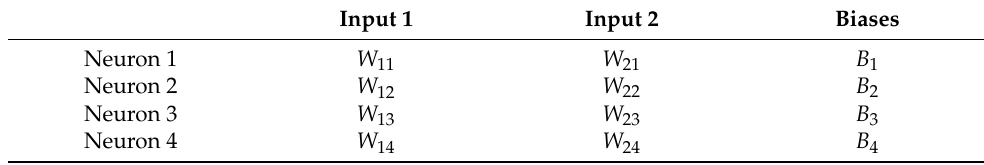
Table A1. Corresponding weights and biases between the input layer and hidden layer 1.